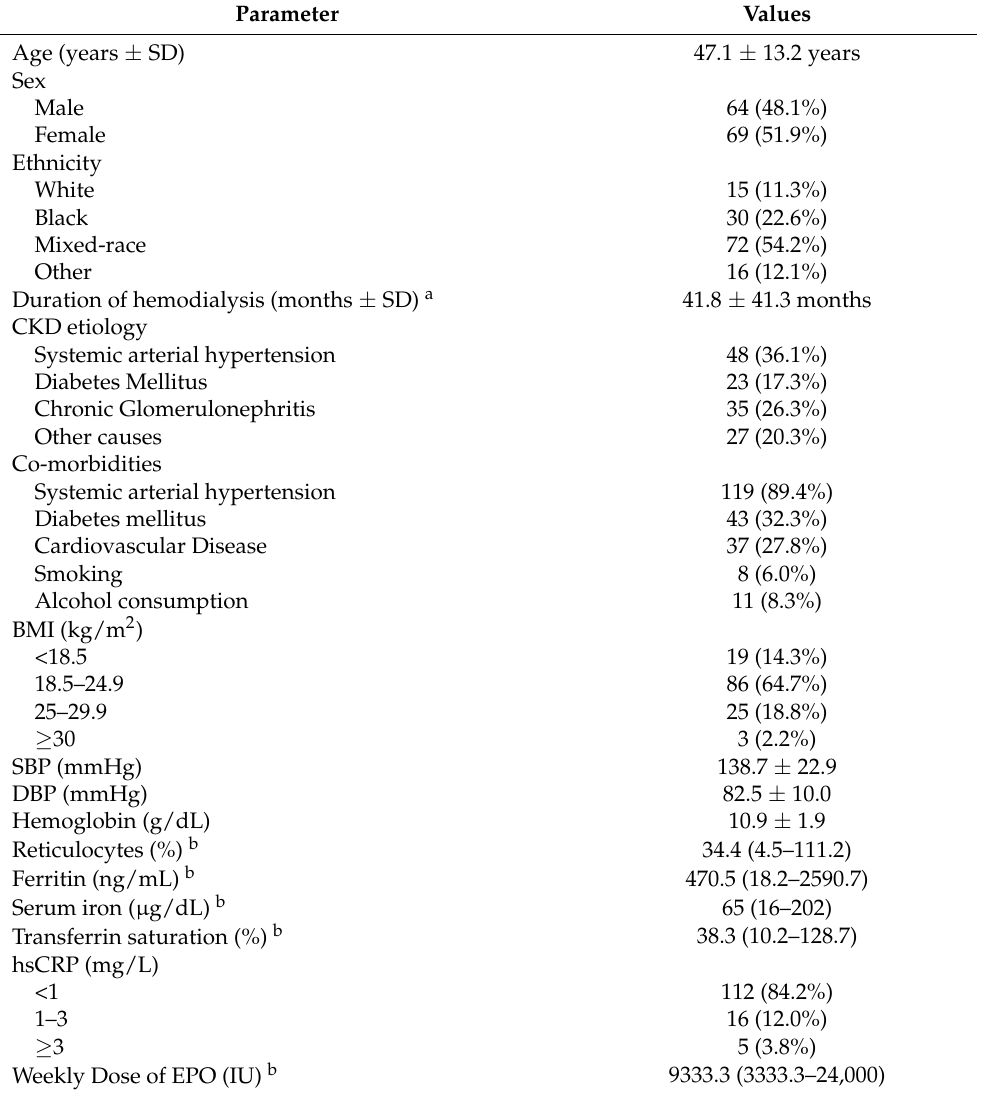
Table 2. Characteristics of the studied sample ( n =